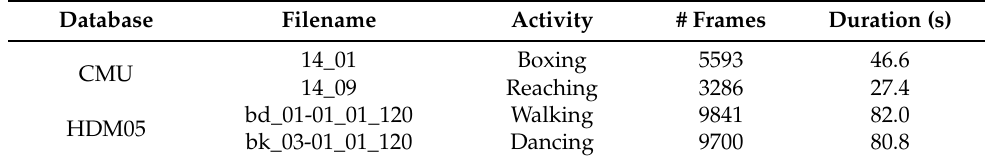
Table 2. MoCap sequences used in the